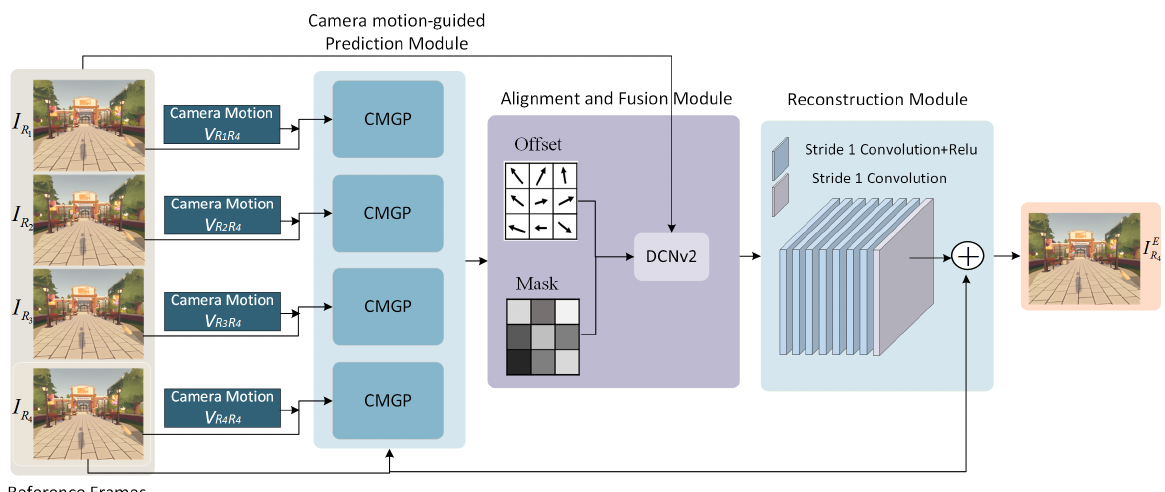
Figure 3. The proposed camera motion-guided network